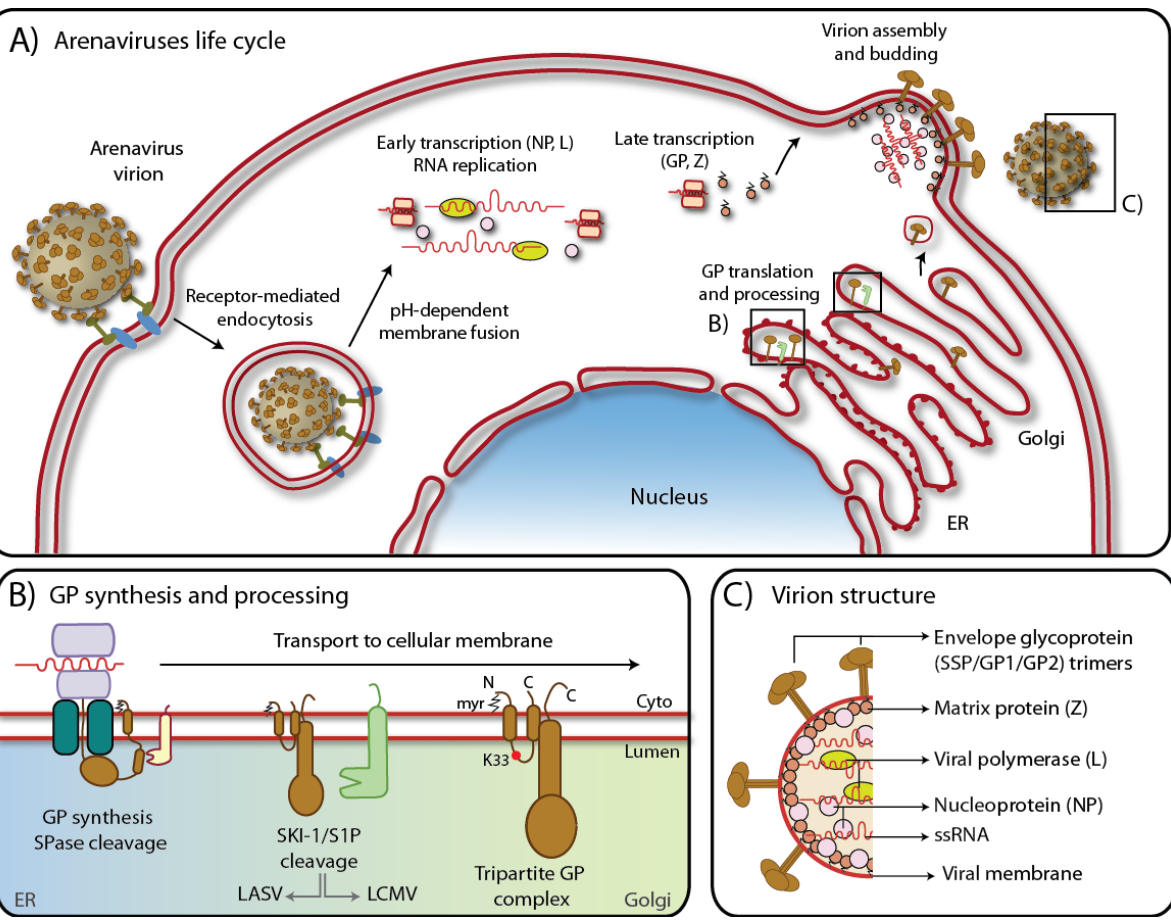
Figure 1. A) Schematic representation of arenavirus life cycle. Boxed regions refer to